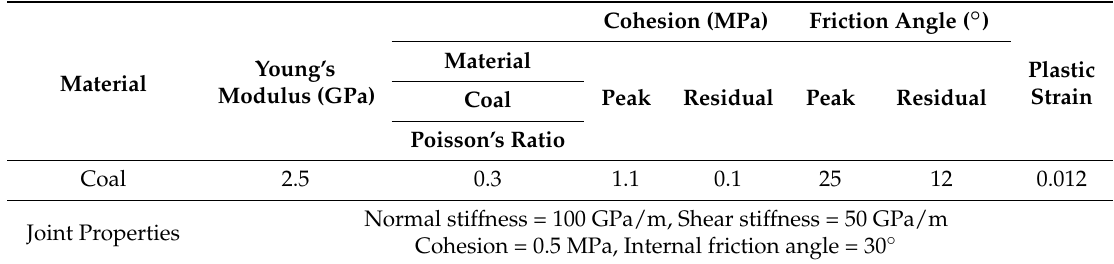
Table 1. Coal and joint